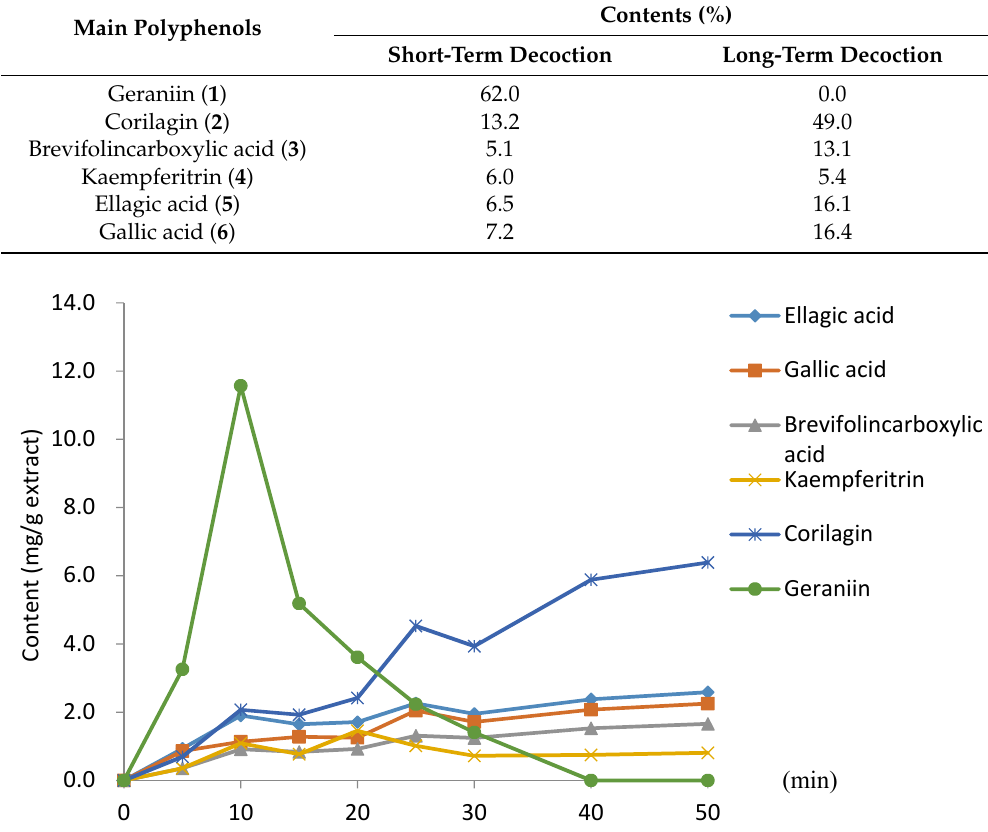
Figure 4. Change in main polyphenol content during G. thunbergii decoction.